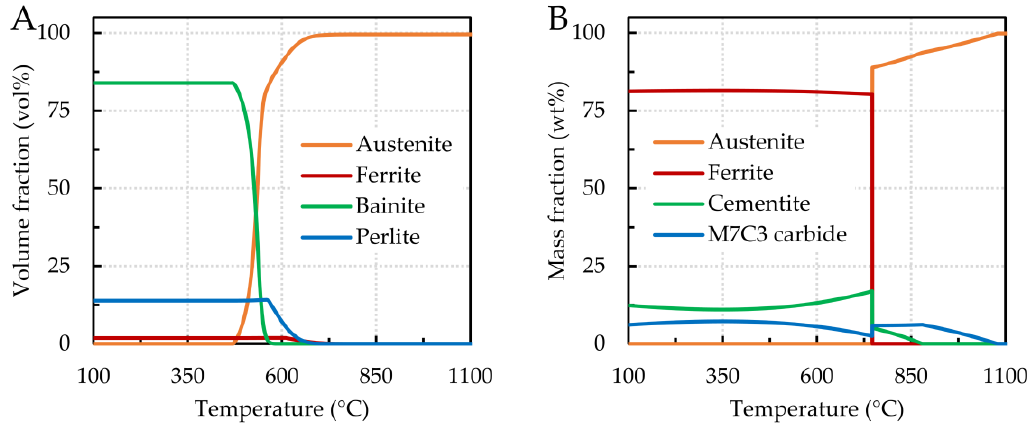
Figure 7. Phase formation as a function of temperature—( A ) sample 7, 0.043 wt% C, 4.863 wt% Cr; ( B ) sample 8, 1.378 wt% C, 4.591 wt%